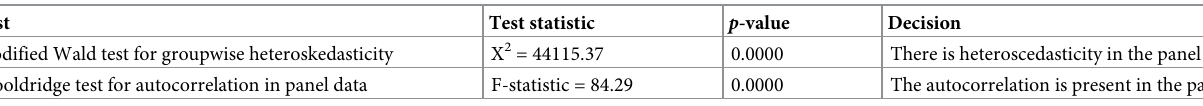
Table 3. The results of heteroscedasticity and autocorrelation. Test